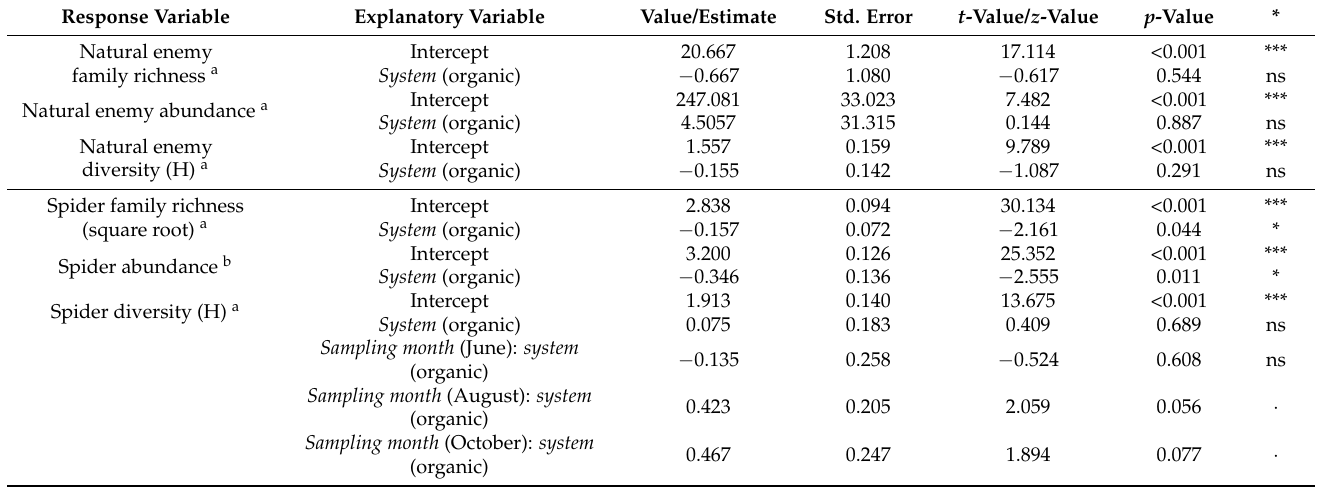
Table 2. Results of the different models for the richness, abundance, and diversity (Shannon index (H)) of natural enemies, spiders, and parasitoids. Estimates, standard errors, test statistics, p -values, and significance levels (ns > 0.1, · < 0.1, * < 0.05, and *** < 0.001) for the intercept and the explanatory variable system , as well as the interaction between the variables system and the sampling month (when significant), are provided. The complete results, including the explanatory variable sampling month , are given in Table S1.